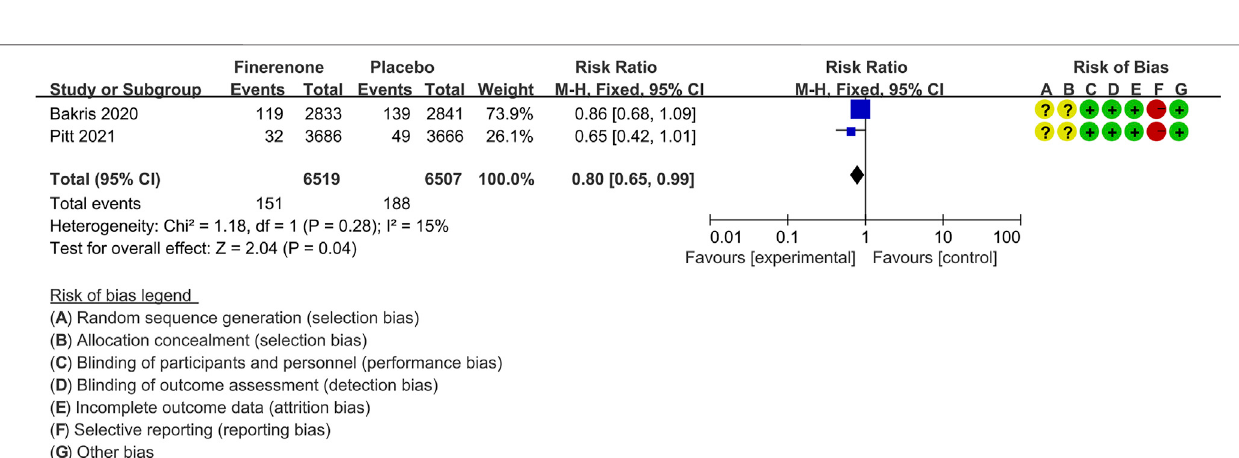
Frontiers in Pharmacology |